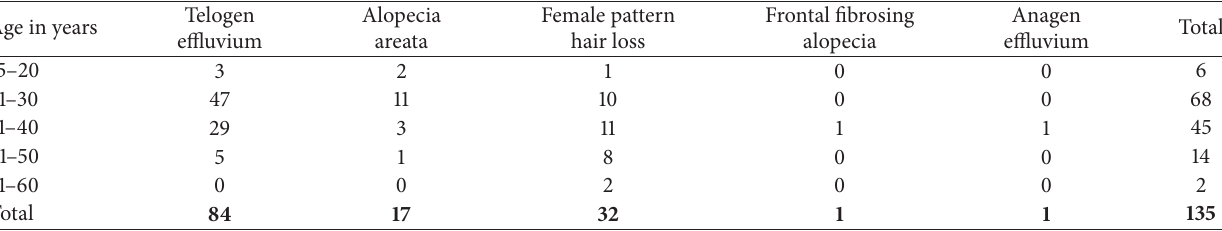
Table 1: Distribution of alopecia in the age groups.